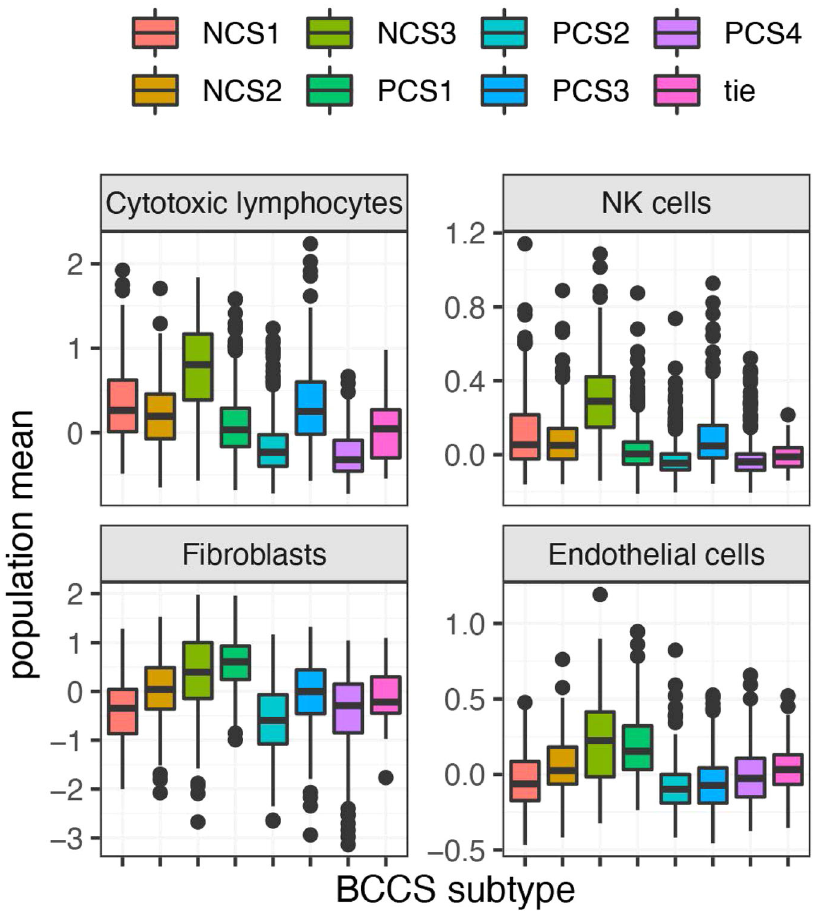
Fig. 5 Distribution by BCCS subtypes of measures of in fi ltration of selected immune and stromal cell populations. This fi gure plots the distributions by METABRIC BCCS subtypes for the degrees of in fi ltration by cells of selected populations, speci fi cally, cytotoxic lymphocytes, NK cells, fi broblasts, and endothelial cells. The degree of in fi ltration by a cell population was assessed with the median-centered MCPcounter population means. The midline in a boxplot indicates the median, the upper and lower edges indicate the quartiles, and the whisker lines are 1.5 times the interquartile